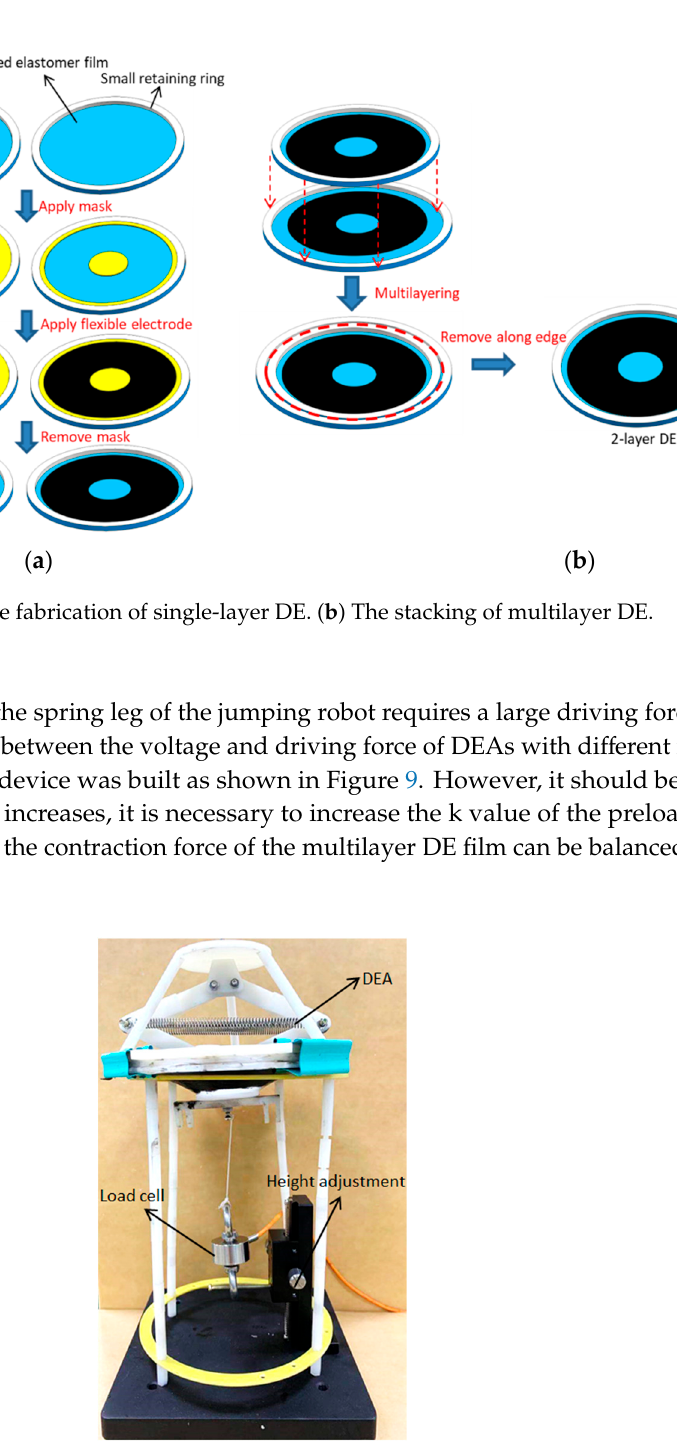
Figure 9. The force–voltage test device for the DEA.